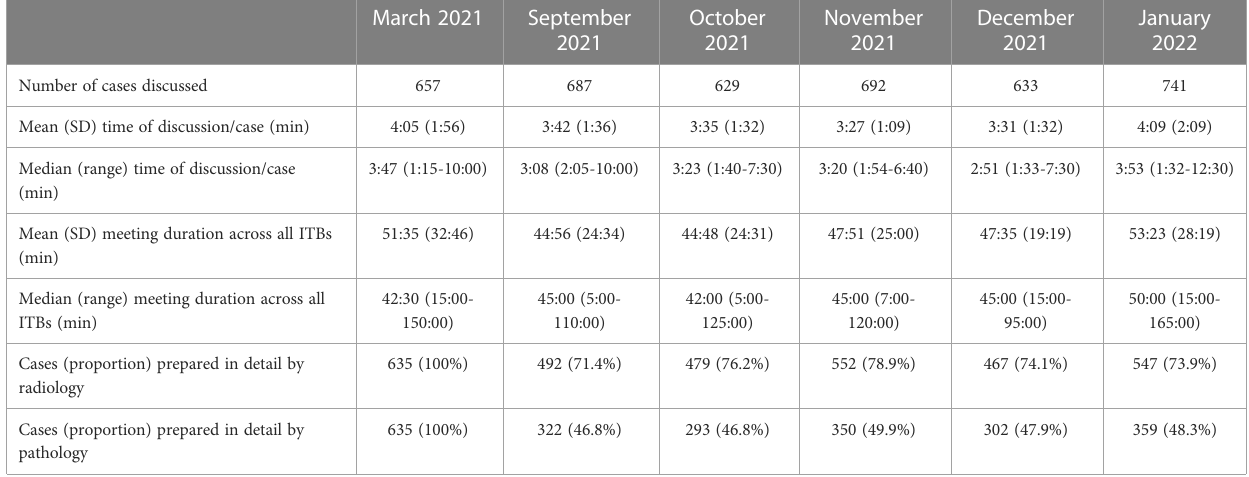
TABLE 2 Characteristics of 12 distinct tumor